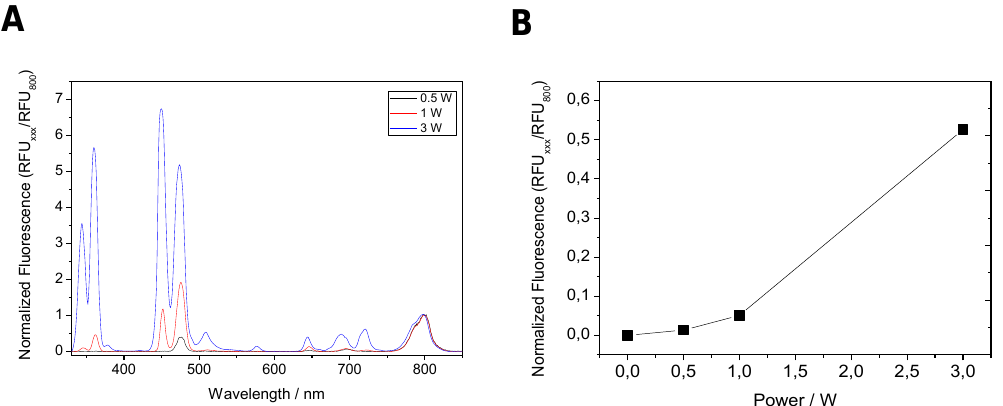
Figure 9. Effect of light power on the excitation of Lys-sGFP immobilized on UCNPs. ( A ) Emission spectra of immobilized Lys-sGFP on UCNPs coated with alginate at different power intensities. All signals were normalized assigning a value of 1 to the peak at 800 nm. ( B ) Emitted fluorescence at 510 nm using different excitation intensities.